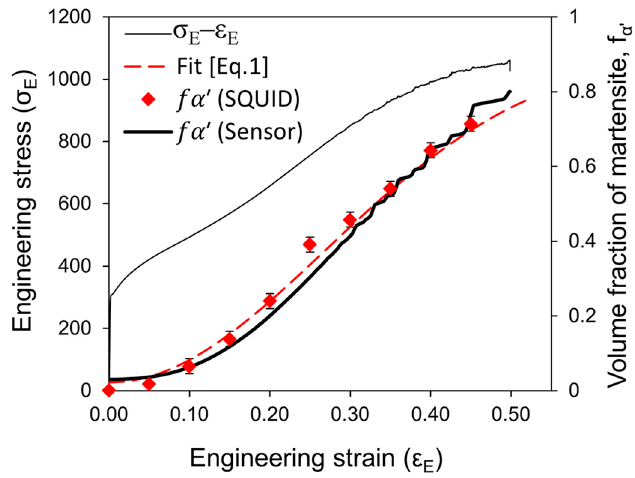
Figure 8. Engineering stress–strain ( σ E - ε E ) curve and evolution of the α′ -martensite volume fraction ( f αʹ ) with ε E obtained by ex-situ magnetization measurements (SQUID), in-situ inductive measurements (sensor) and as predicted by the kinetics model.